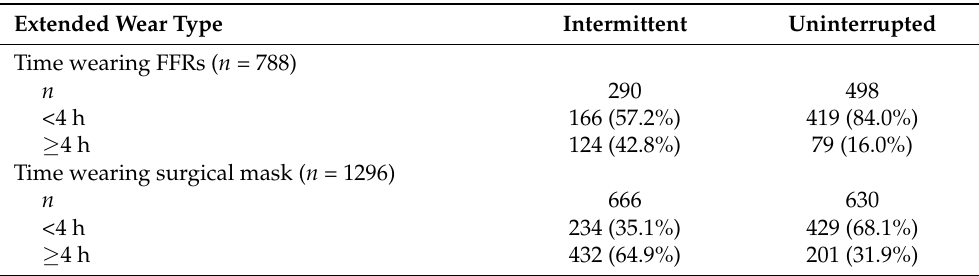
Table 4. Longest reported amount of time using N95-type filtering facepiece respirators (FFRs) and surgical masks during COVID-19 surge one.